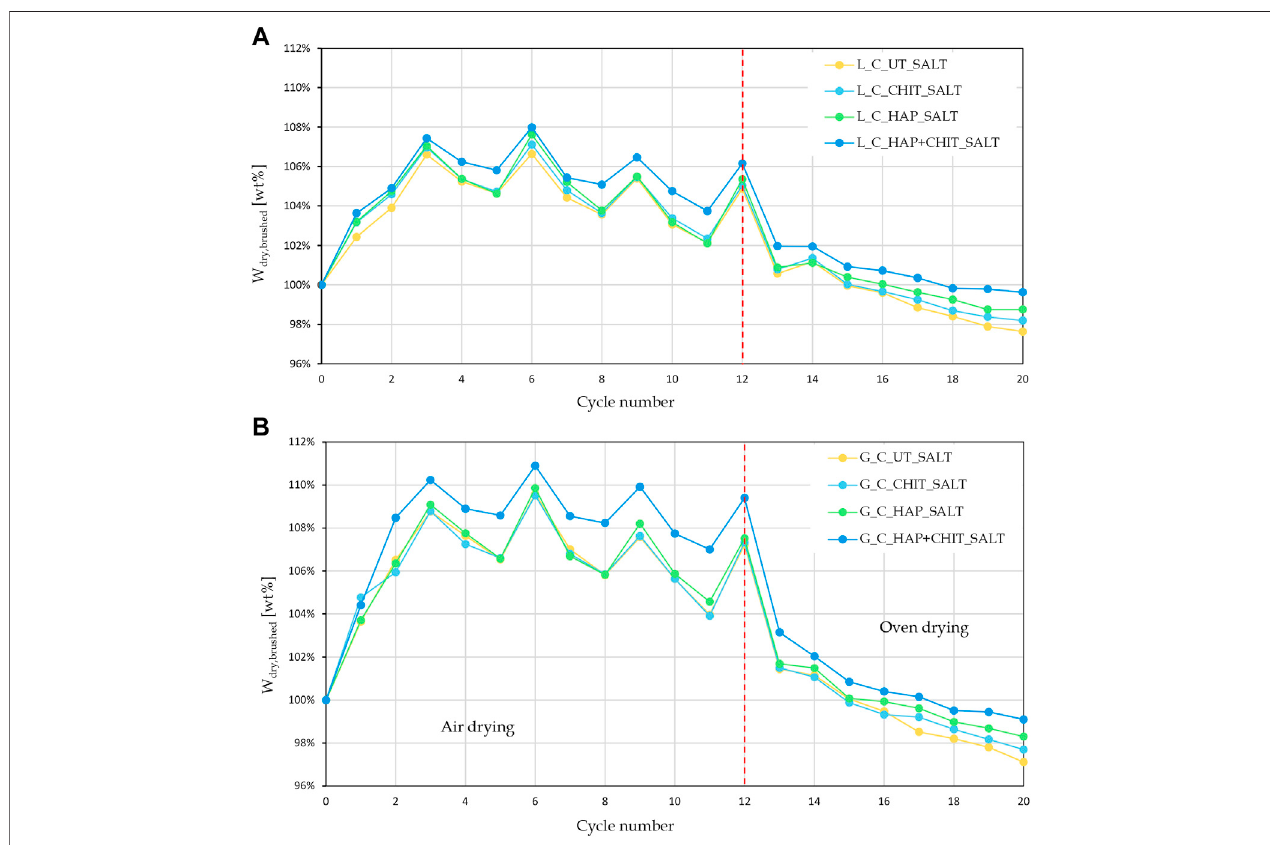
FIGURE 4 | Weight variation of the cylindrical samples after drying and brushing, at each cycle of the salt crystallization test for: (A) Lecce stone (UT and with different treatments) and (B) Globigerina limestone (UT and with different treatments).